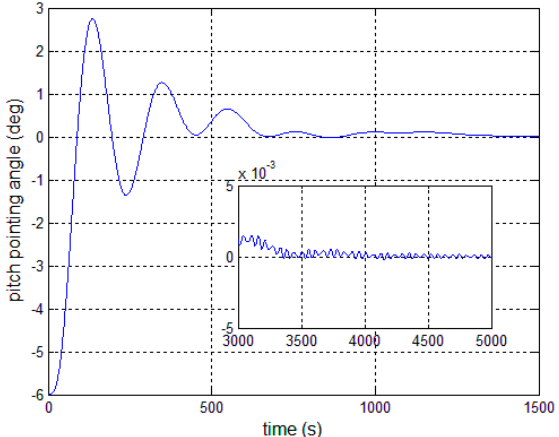
Figure 15. Antenna pitch angle error—controller, Equation (31).